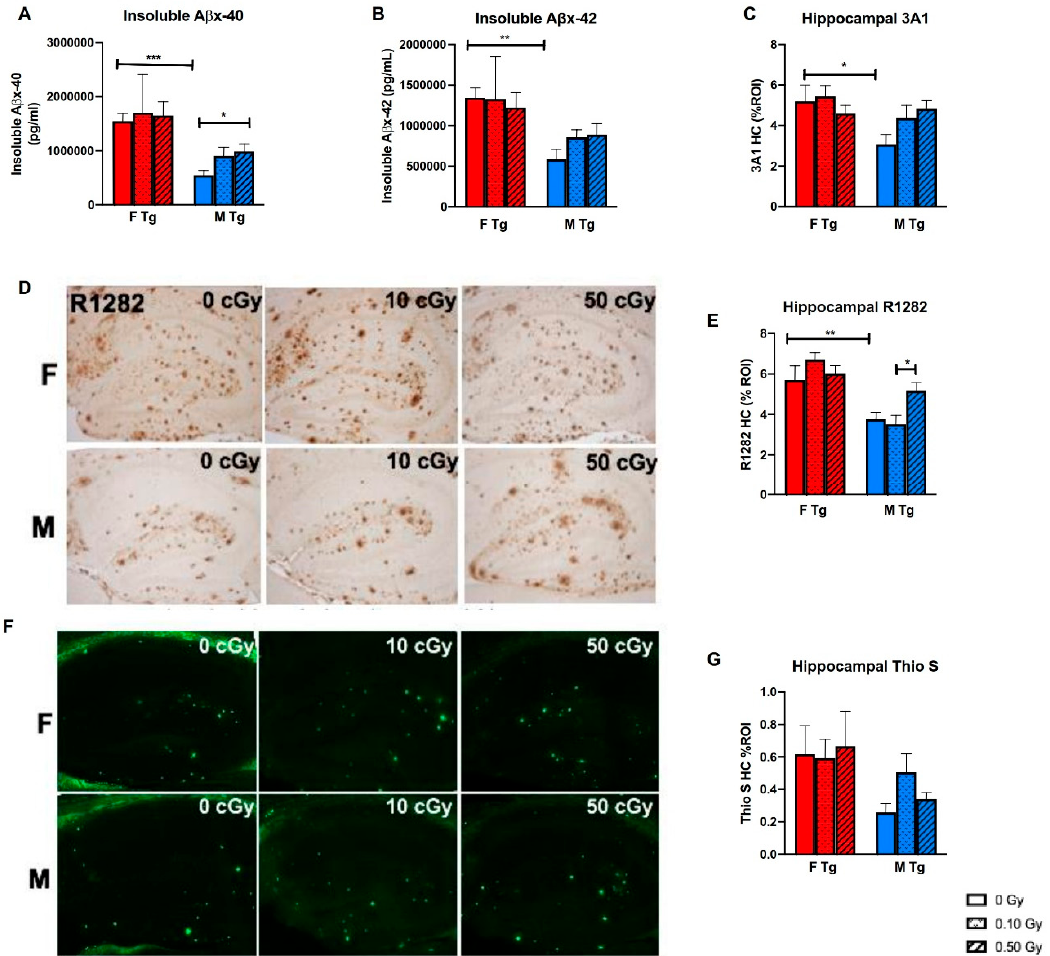
Figure 5. 56 Fe irradiation caused elevated cerebral A β levels in APP/PS1 males, but not in APP/PS1 females, at 8 months post-irradiation. ( A , B ) Insoluble A β x-40 ( A ) and A β x-42 ( B ) levels were quantified by an MSD 4G8 A β -triplex ELISA ( n = 9–16 mice/group). ( E – G ) Amyloid pathologies were assessed by R1282 immunohistochemical (IHC) staining ( E ) and were quantified by the % region of interest (%ROI) in the brain regions of hippocampus ( D ) using the BioQuant program ( n = 6–9 mice/group), and were further confirmed by 3A1 immunoreactivity ( C ). Fibrillar A β was measured by Thioflavin S staining ( G ), and % ROI was quantified in the hippocampus ( F ) using ImageJ ( n = 6–9 mice/group). * p < 0.05, ** p < 0.01, and *** p < 0.001. Data were analyzed by 2-way ANOVAs followed up with 1-way ANOVAs with Tukey comparisons and planned, unpaired, 2-tailed t tests between sham groups as necessary.